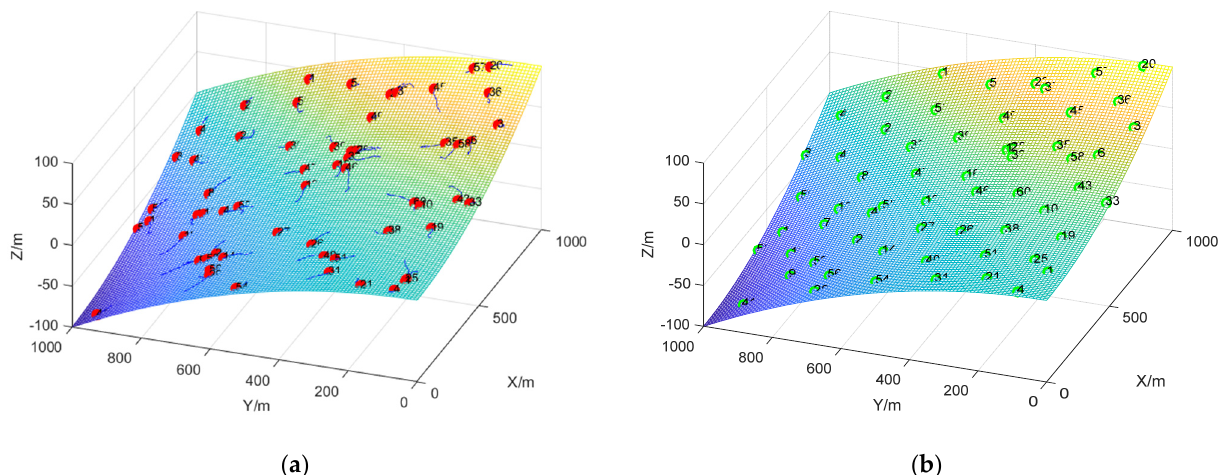
Figure 10. 3D surface node movement process via random initialization. ( a ) Initial position and movement track of nodes. ( b ) Optimized node deployment.